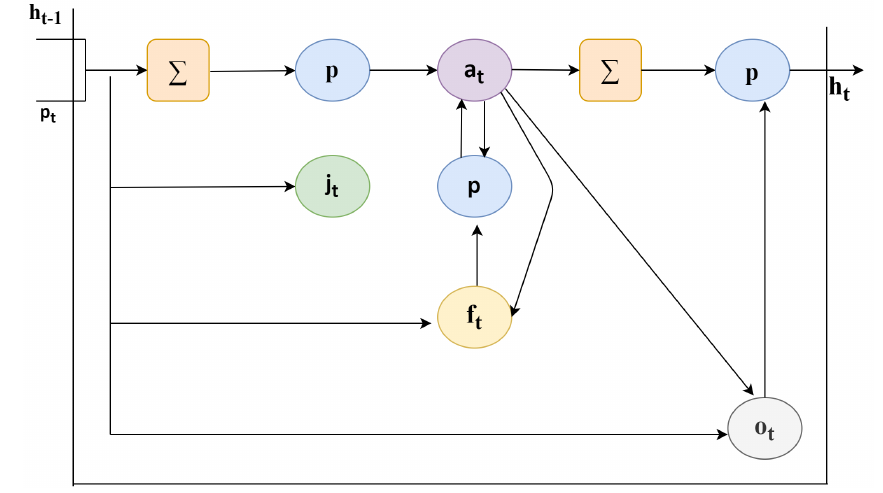
Figure 5. Lightweight deep learning classifier-long short term memory